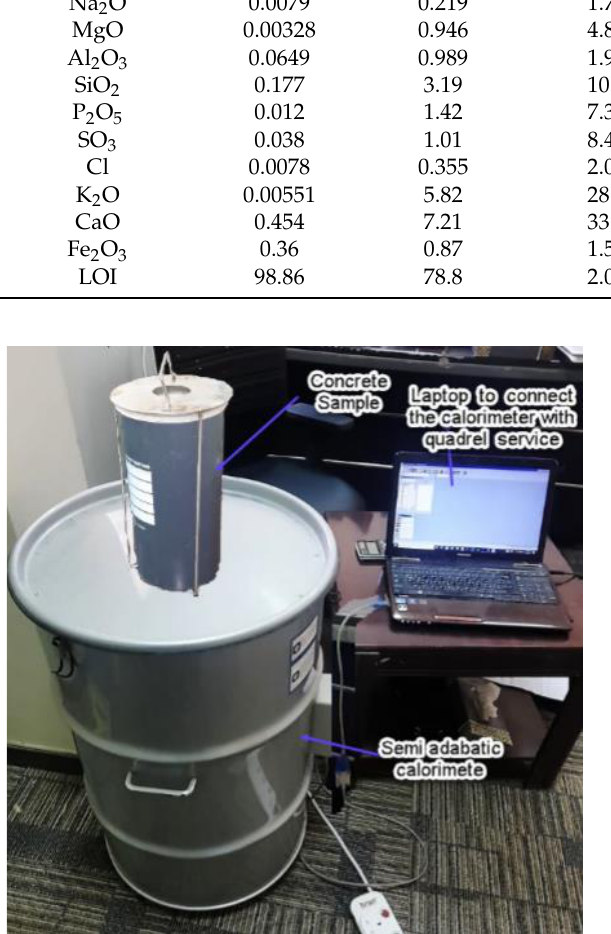
Figure 10. iQDrum for measuring heat and temperature generation in